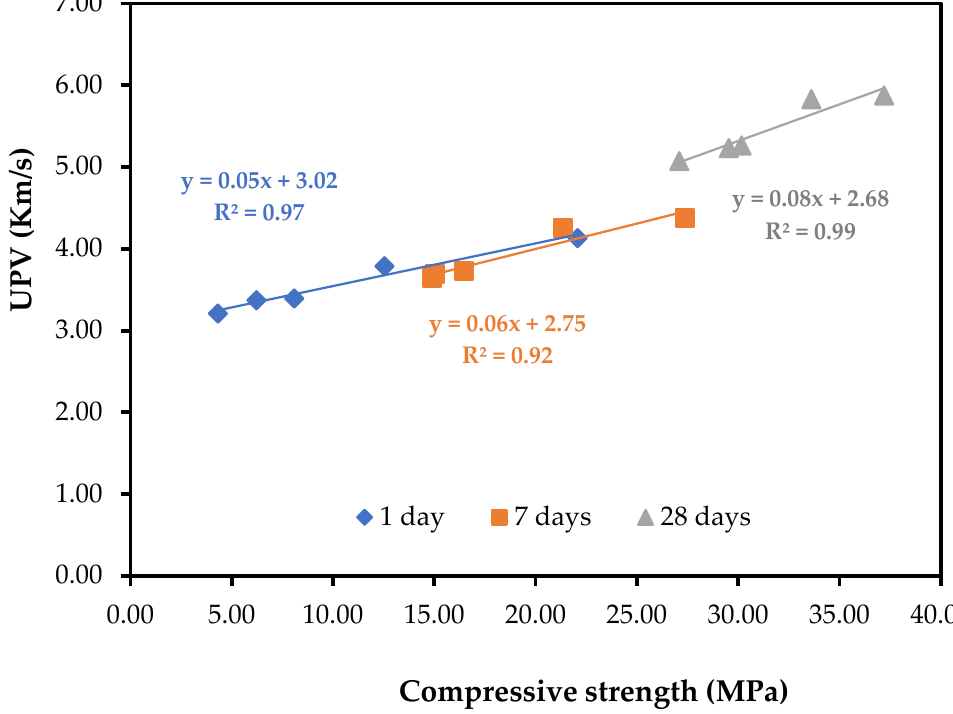
Figure 9. Correlation between UPV and compressive strength at different curing ages .